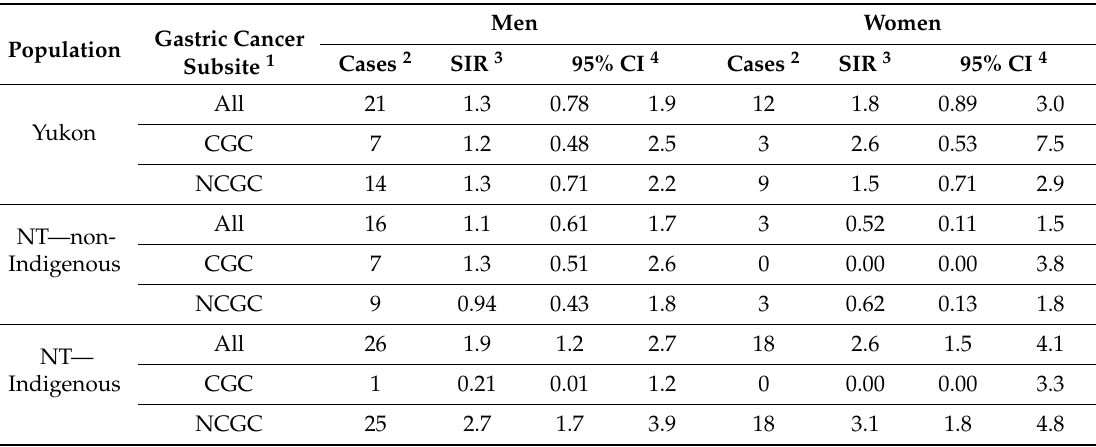
Table 2. Number of cases and estimated standardized incidence ratios (SIR) comparing northern populations to Canada as a whole on gastric cancer incidence rates by gastric cancer subsite, population, and sex; various years.